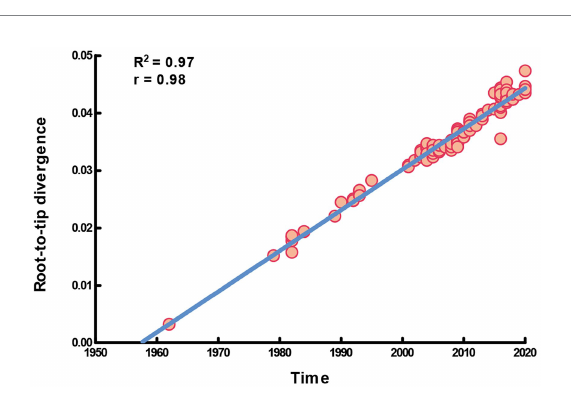
FIGURE 1 Temporal signal plot of full-length S gene of HCoV-229E. The y-axis and x-axis denoted the regression of root-to-tip divergence against sampling